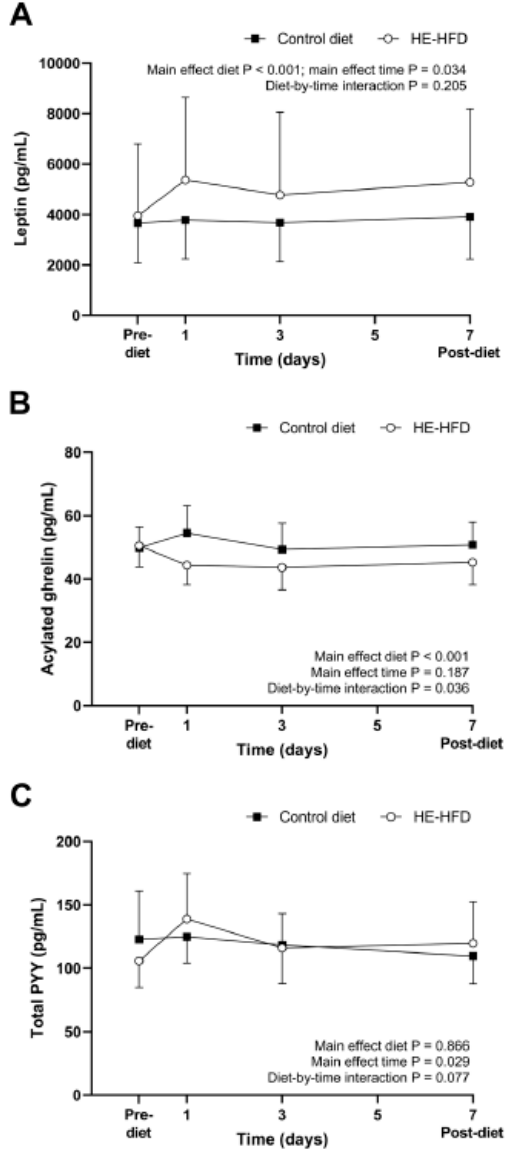
Figure 4. Fasted plasma concentrations of ( A ) leptin, ( B ) acylated ghrelin and ( C ) total peptide YY (PYY) during the seven-day control diet and hyperenergetic high-fat diet (HE-HFD) in 12 healthy men. Values are geometric mean (95% confidence interval).